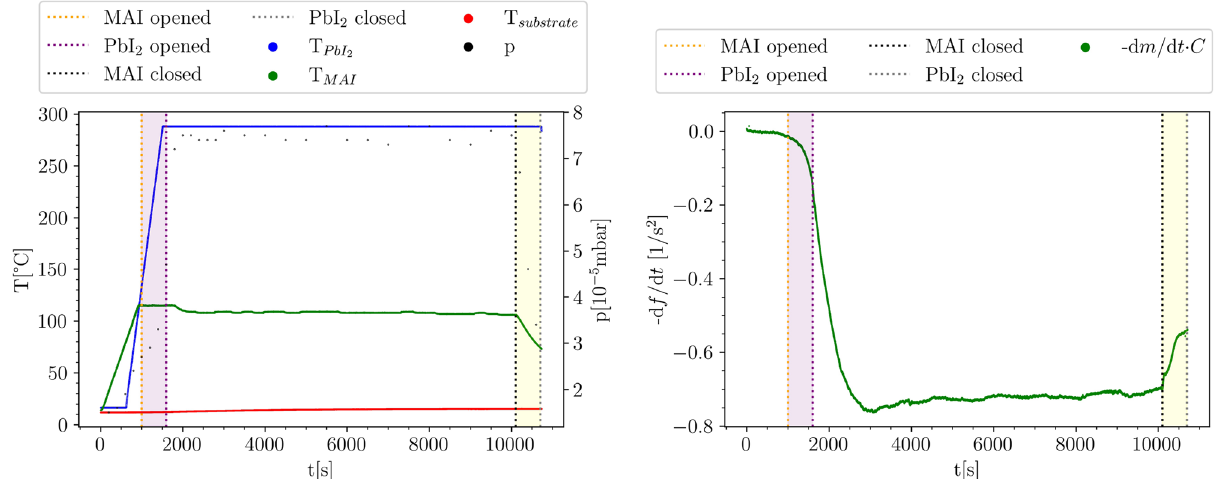
Figure 2. Pre-evaporation of MAI in combination with post-deposition of PbI 2 (Eva 4). The left plot shows the temperatures and pressure for the whole evaporation time, the right image visualizes the time derivative of the frequency calculated from the measured frequency by the